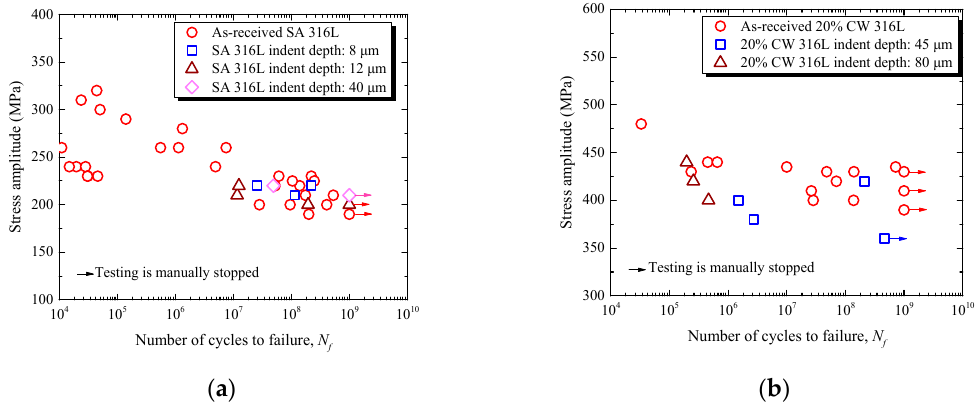
Figure 4. ( a ) The S-N curves of SA 316 with and without indents. ( b ) The S-N curves of 20% CW 316 with and without indents.